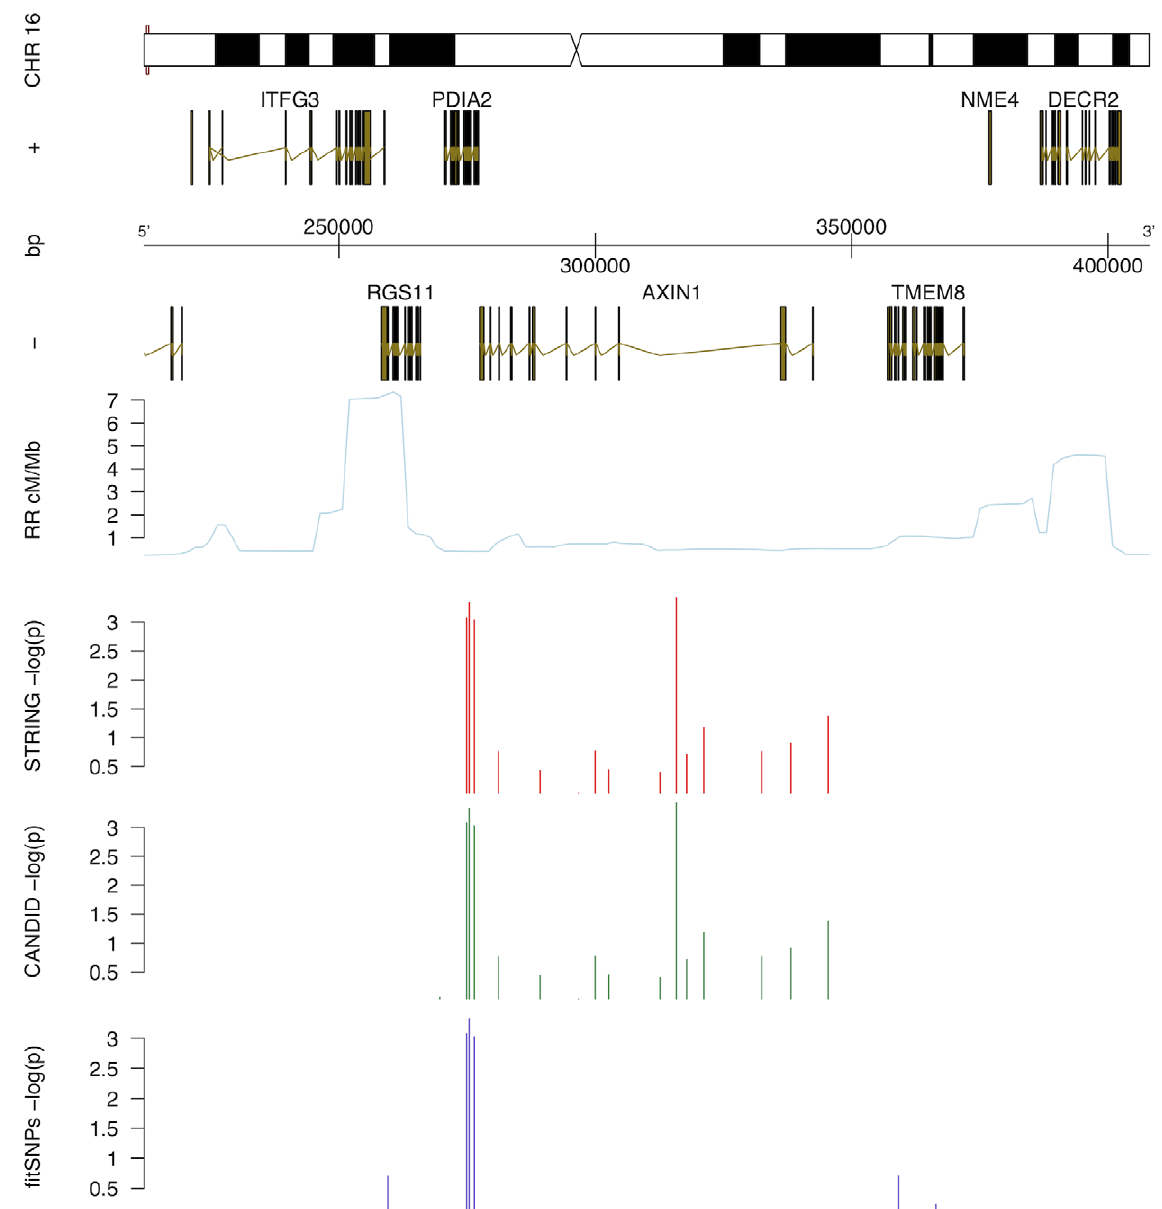
Figure 3. BAV Associated Haplotype Spanning PDIA2 and AXIN1. Data from three approaches and relevant genomic features extracted from the Ensembl 54 database are depicted. At the top of the plot is an ideogram depicting a location on chromosome 16; the small red box delimits a region between base pair 212416 and 407490, displayed immediately below the ideogram (track labeled ‘‘bp’’ which also indicates the 5 9 to 3 9 orientation of the plot). Annotated gene content is displayed on positive (denoted by ‘‘ + ’’) and negative (denoted by ‘‘ 2 ’’) strand. The four graphical data-panes indicate RR cM/Mb: relative recombination rate in centimorgans per megabase as derived from HapMap build 36. STRING 2 log(p), CANDID 2 log(p), and fitSNPs 2 log(p): 2 log 10 uncorrected p-values observed in each of the three indicated schemes. All probes analyzed in the region by each respective schema are represented by a peak. The region between the two tallest peaks in the STRING and CANDID plots delineates the observed haplotype detailed in Figure 4.